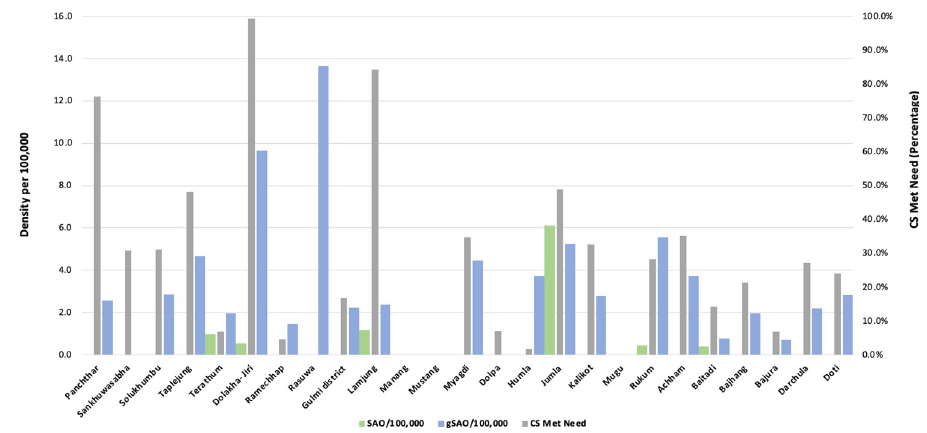
Fig 3. CS met need compared to gSAO and SAO densities per